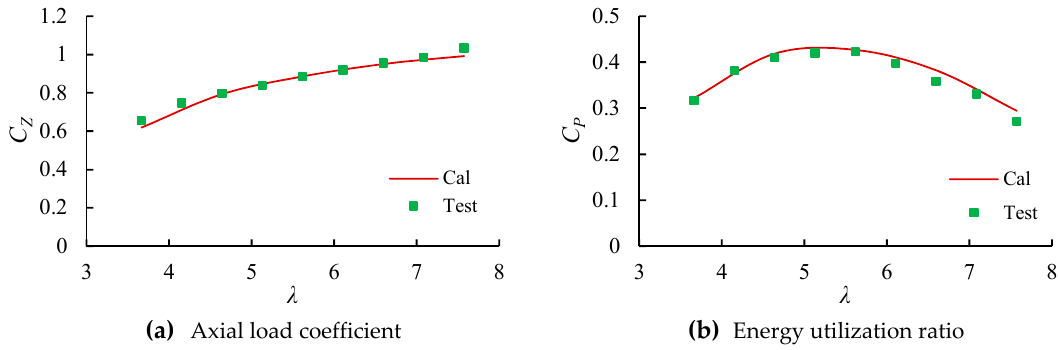
Figure 4. Comparison between calculated and experimental values.